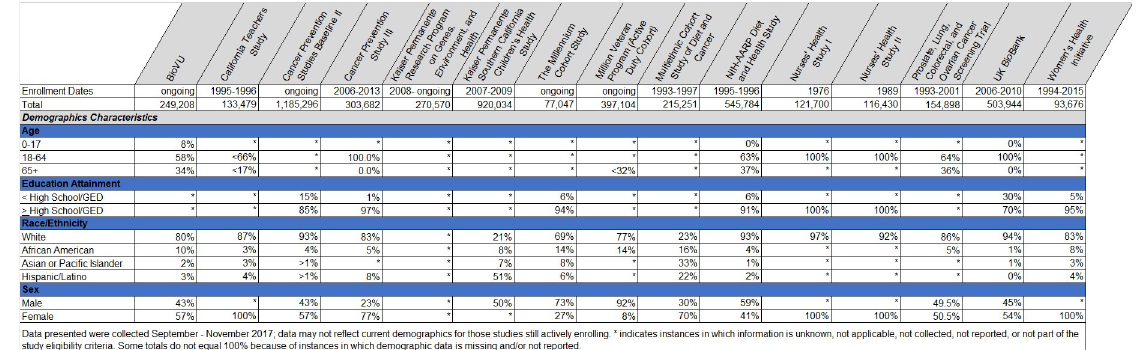
Fig 2. Core demographic characteristics of similar cohorts evaluated to support development of the All of Us guide for diversity and inclusion.